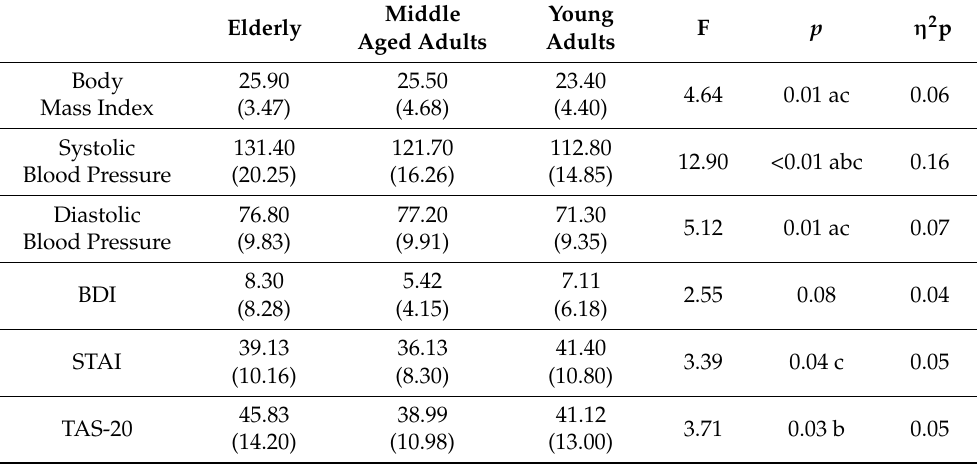
Table 3. Between-group comparisons of physiological and psychological variables.